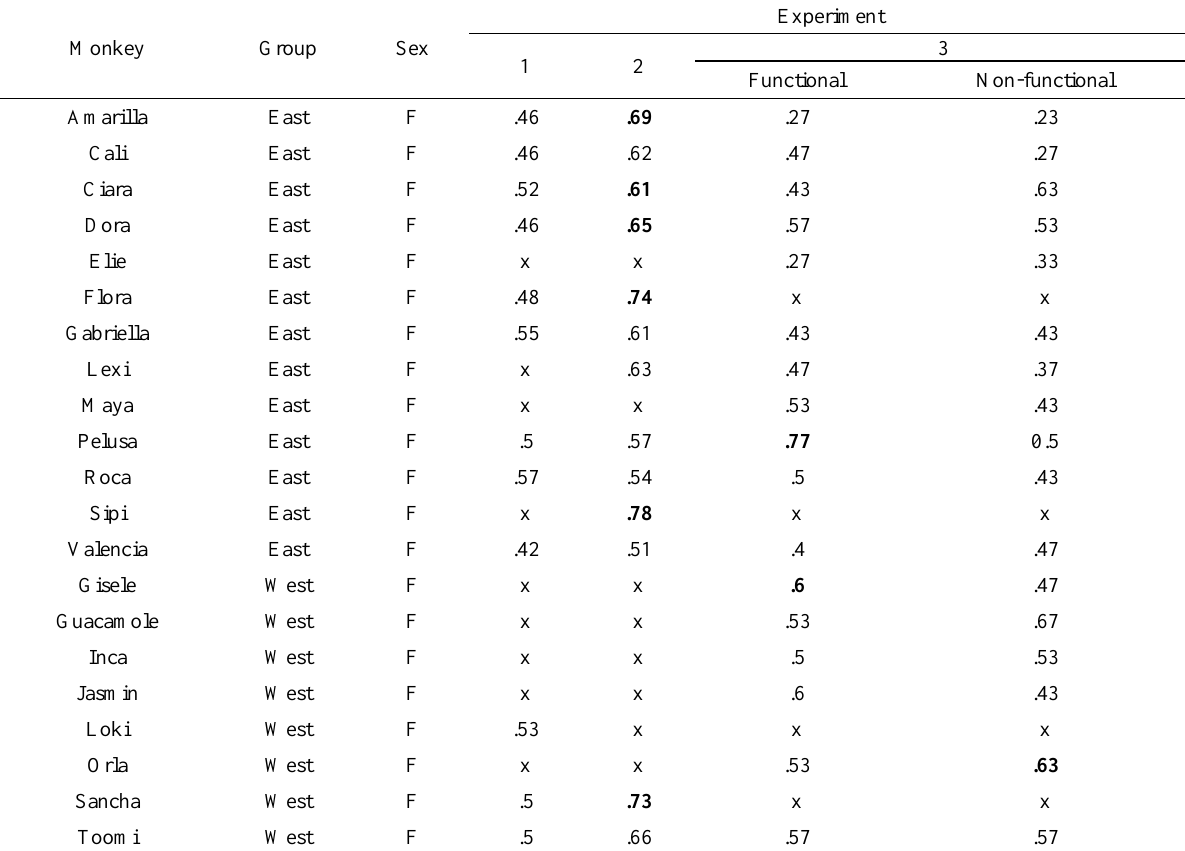
Squirrel Monkey Participants’ Details and the Experiments in which They